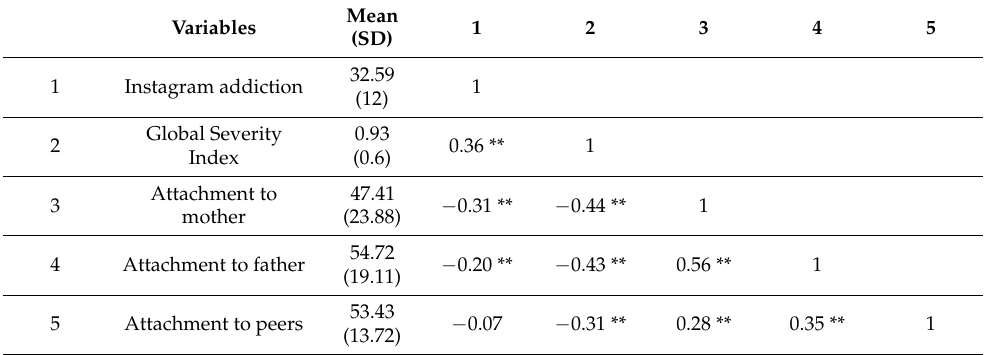
Table 1. Means, standard deviations and correlations of the main variables.